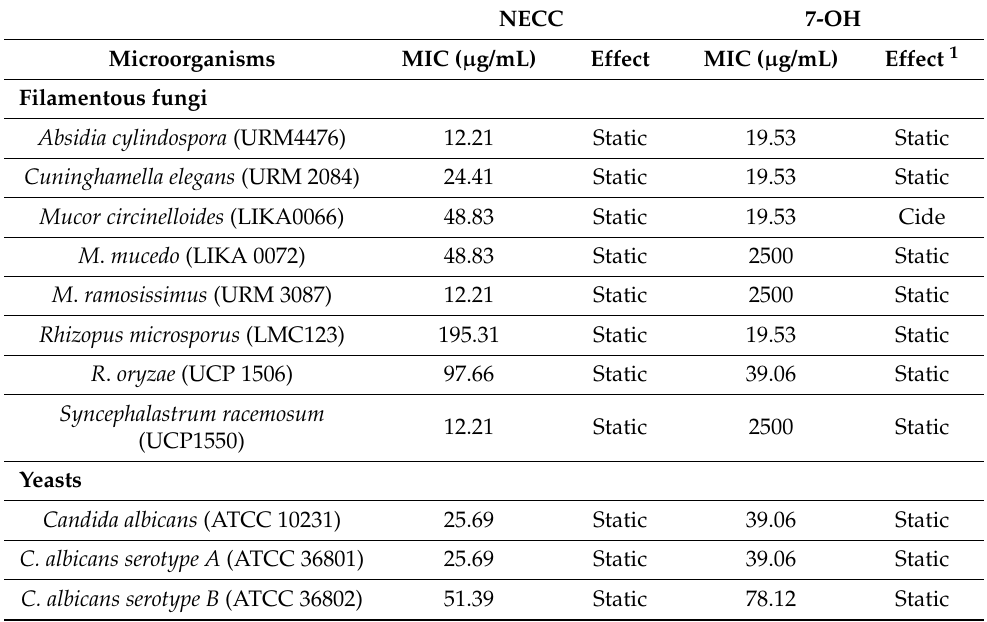
Table 2. Minimal inhibitory concentration (MIC) of NECC and 7-hydroxycalamenene